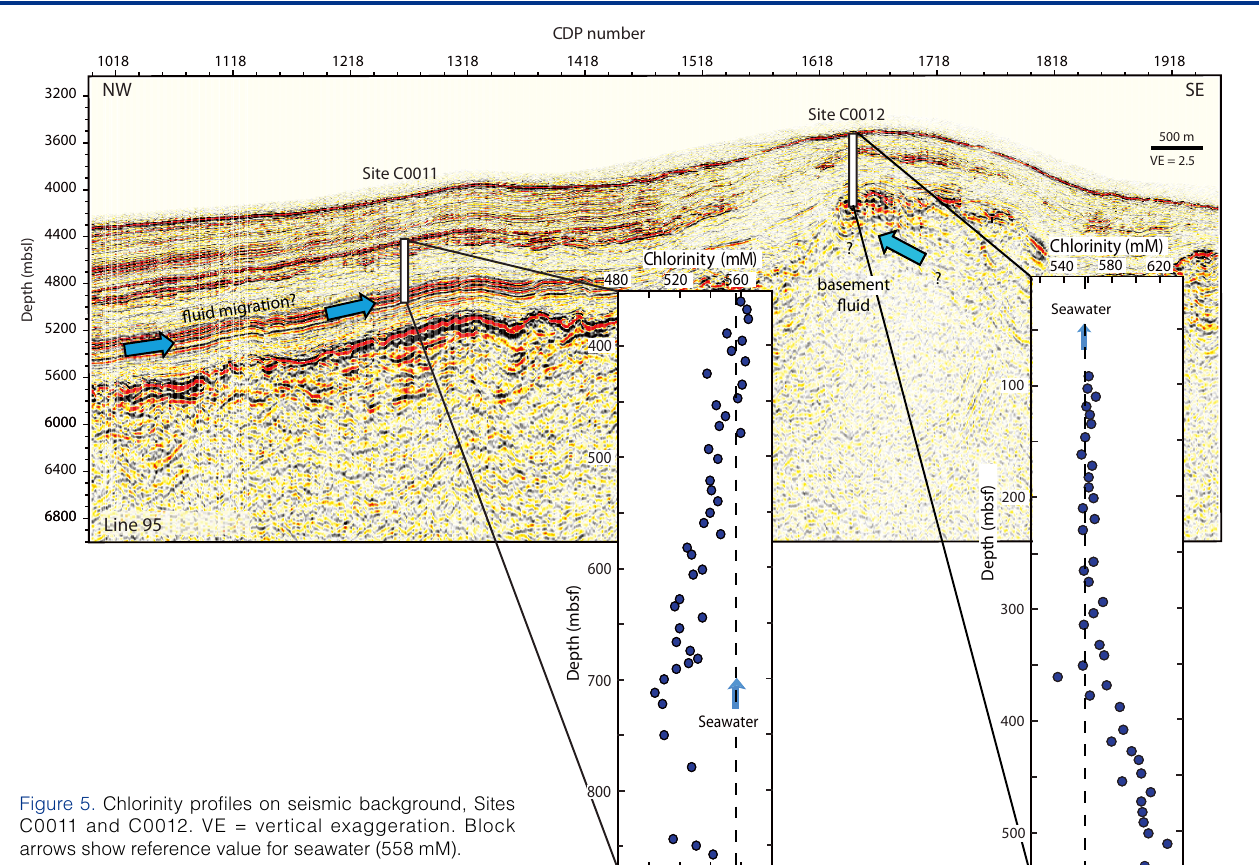
Figure 5. Chlorinity profiles on seismic background, Sites C0011 and C0012. VE = vertical exaggeration. Block arrows show reference value for seawater (558